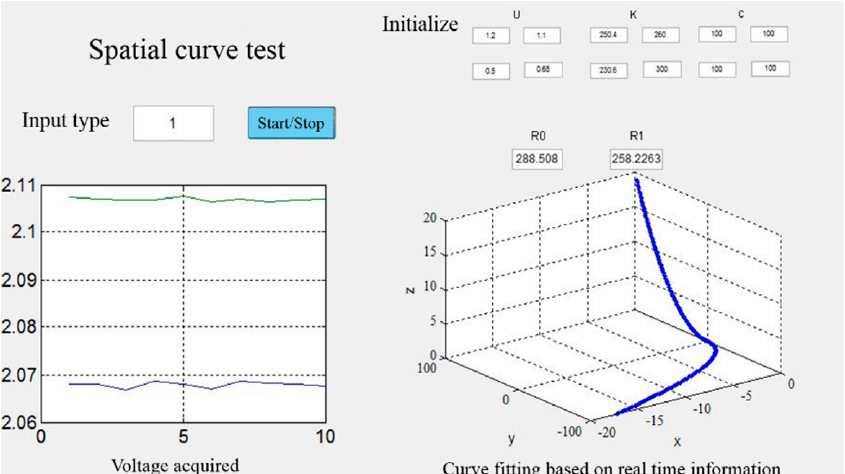
Figure 18. Double arc experiment. Sensors 2018 , 18 , x FOR PEER REVIEW